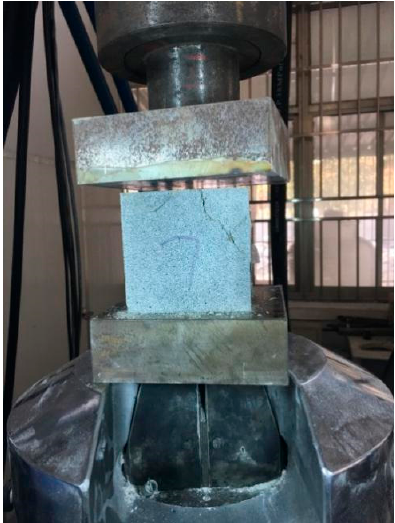
Figure 7. Schematic diagram of the uniaxial compression